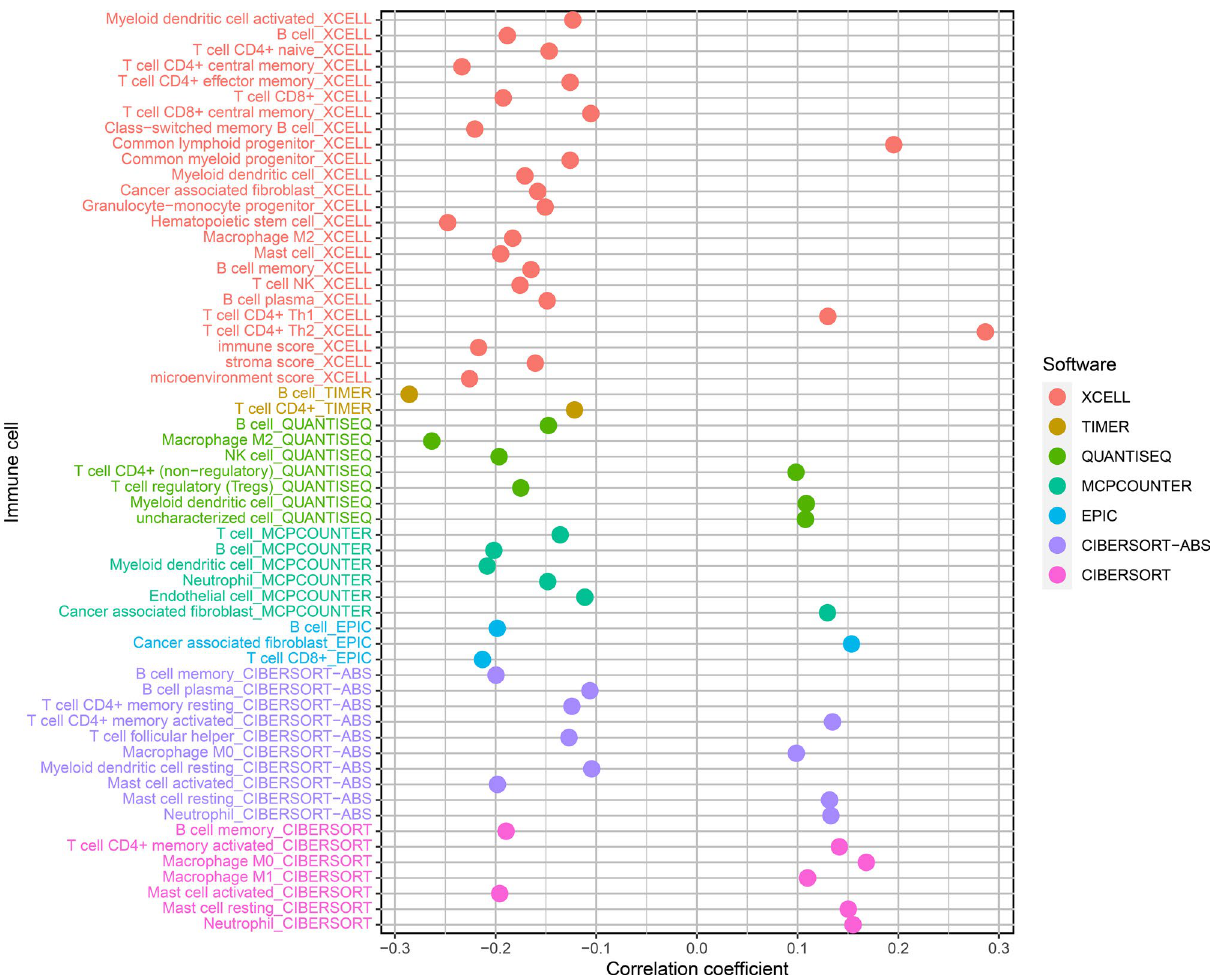
Figure 7. Positive and negative associations between immune-cell infiltration and risk score. Correlation coefficient > 0: positive correlation; Correlation coefficient < 0: negative